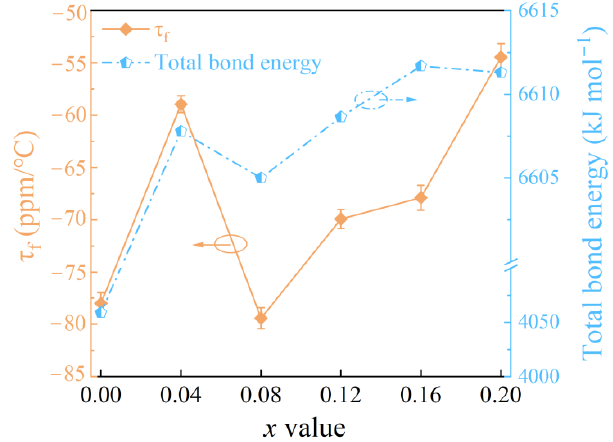
Figure 7. The τ f value and the total bond energy of Mg 1 − x Cu x Al 2 O 4 ceramics sintered at 1550 °C.